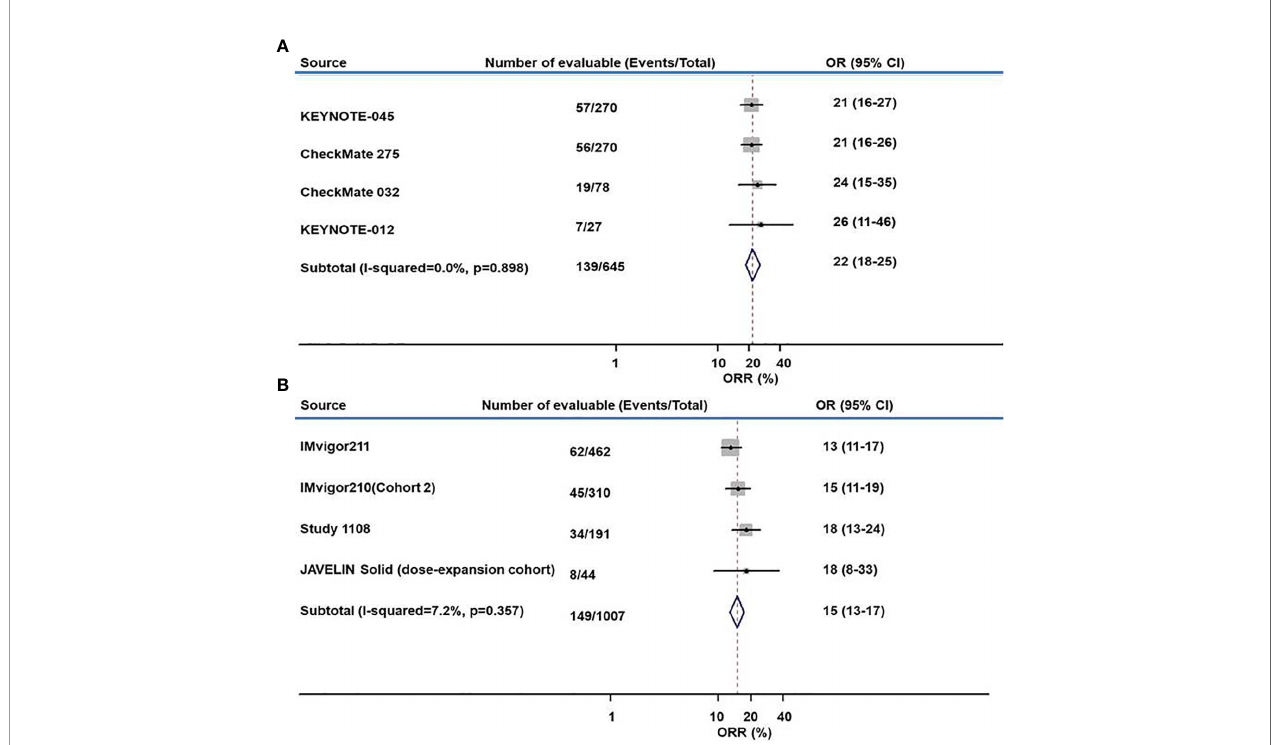
FIGURE 2 | Meta-analysis of pooled odds ratios of an objective response to anti – PD-1 and anti – PD-L1 therapy. (A) anti – PD-1, (B) anti –